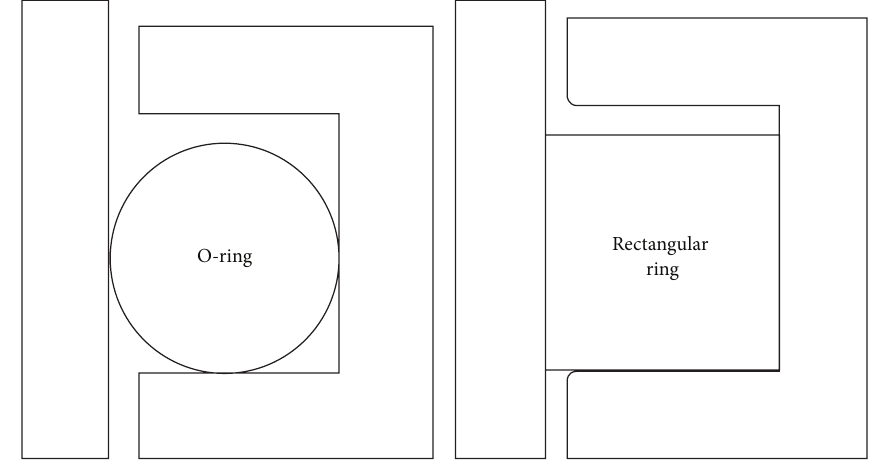
Figure 13: Schematic diagrams of O-ring and rectangular ring.